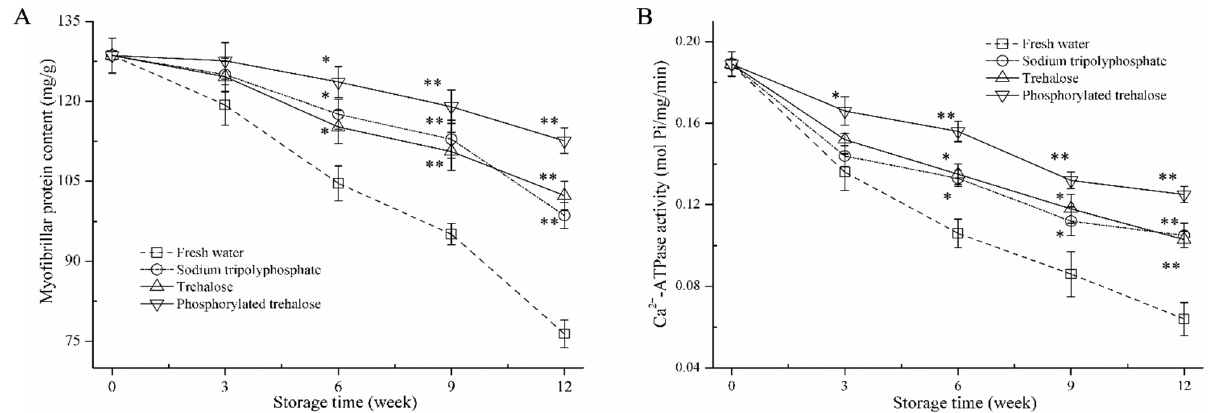
Figure 1. Myofibrillar protein content ( A ) and Ca 2+ -ATPase activity ( B ) in peeled shrimp soaked with fresh water, sodium tripolyphosphate, trehalose, and phosphorylated trehalose during frozen storage. * p < 0.05 and ** p < 0.01 compared with the fresh water treatment at the same point.